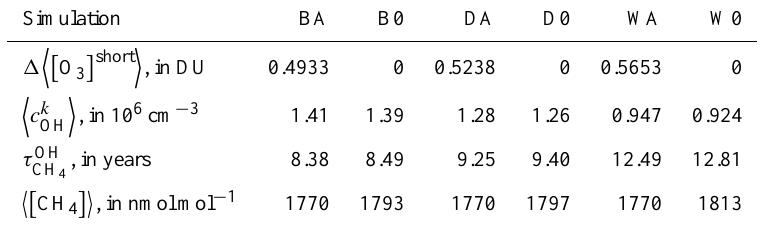
Table 3. Global annual mean parameters relevant for radiative forcing calculations. All are evaluated for the region below an upper boundary D(cid:2) E of 50hPa. 1 O 3 (cid:3) short is the short-lived increase of the ozone burden due to aircraft NO x emissions, compared to the respective base case. D E c k ) is calculated from the [OH] field of the respective simulation, but is the hydroxyl radical concentration. Methane lifetime ( τ OH OH CH 4 [CH 4 ] is always from BA. (cid:10)(cid:2) CH 4 (cid:3)(cid:11) is the methane burden, derived independently for each sensitivity block from monthly mean values of relative methane lifetime change. The same observation based value of (cid:10)(cid:2) CH 4 (cid:3)(cid:11) is assumed for BA, DA and WA as a reference to calculate a hypothetical methane burden for B0, D0 and W0,